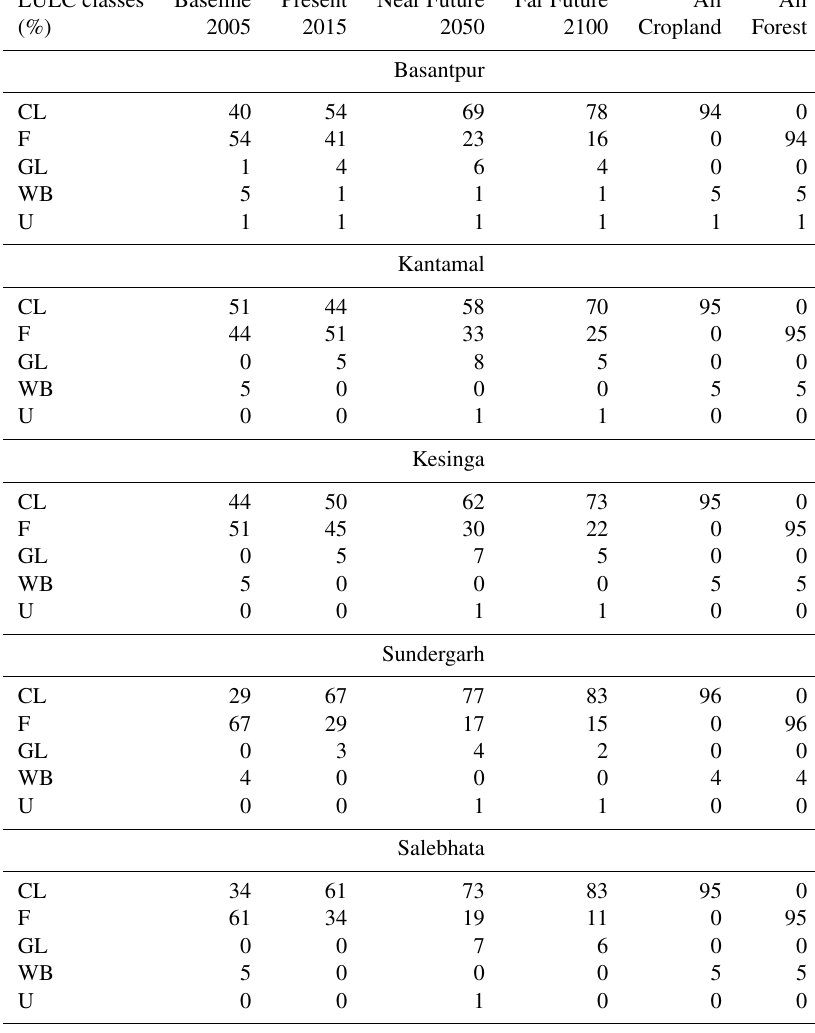
Table 3. Land cover area change across all subcatchments of the Mahanadi river basin. LULC